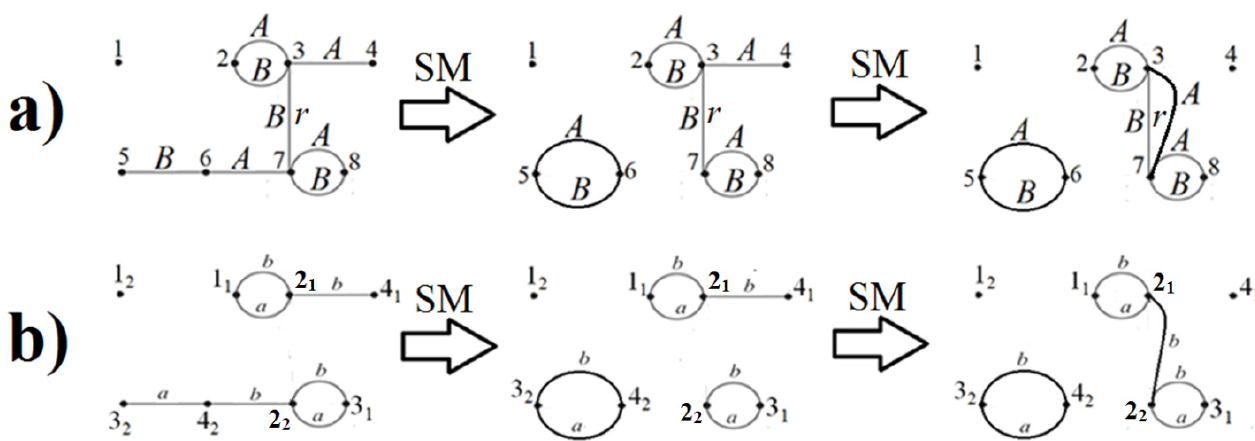
Figure 5. ( a ) Reduction of A * B to a ch-final form by the algorithm from [10]. ( b ) Corresponding reduction of a + b to a quasi-final form (numbering of edge endpoints is not shown). The graph a + b’ is not shown but can easily be composed given a + b .